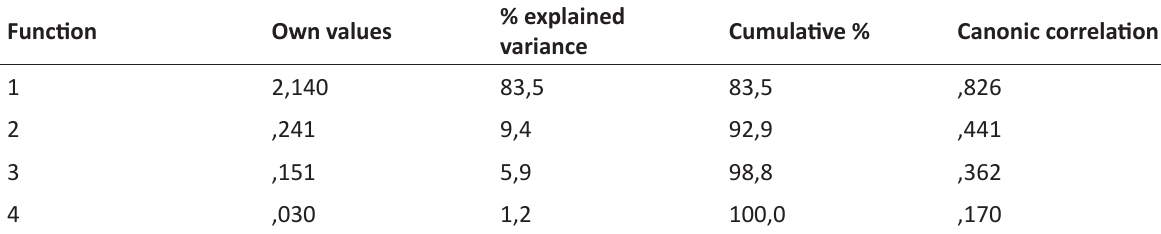
Table 2. Canonical discriminant function. Own values. Boys aged 8 years old